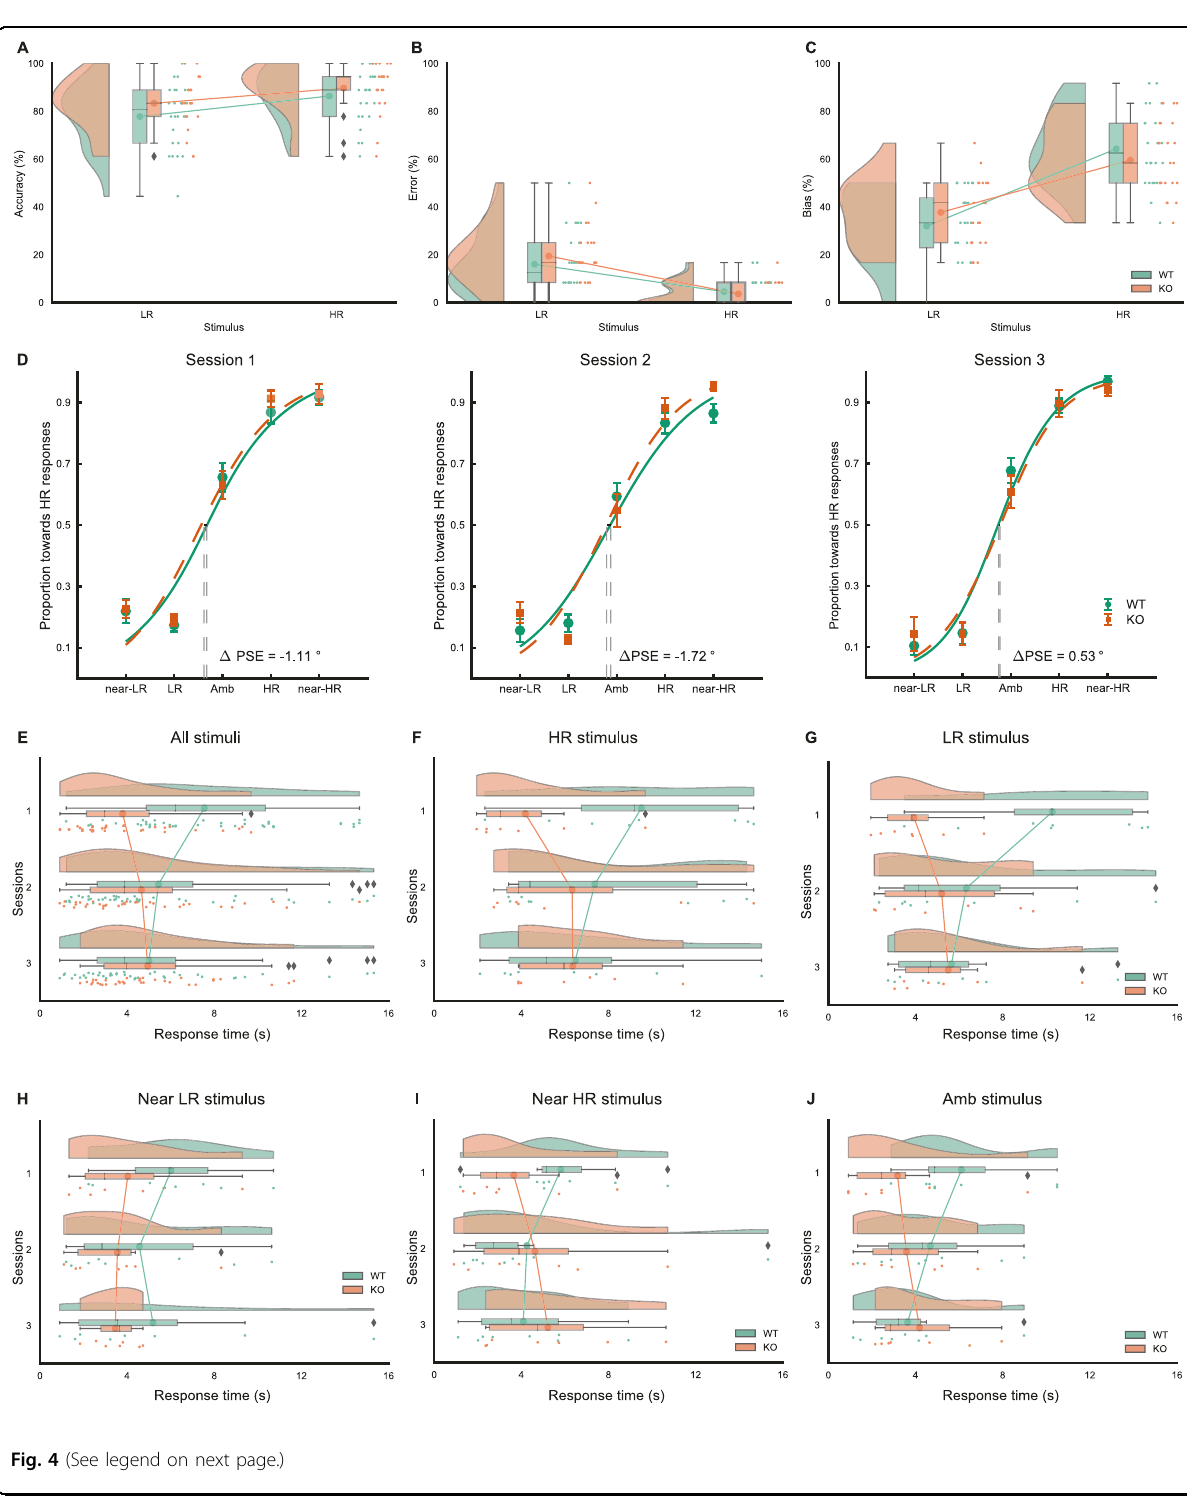
ambiguous stimuli. Also, generalization curves were similar between KO and WT rats, and as the similarity was closer to CS, the responses to GS were more robust.